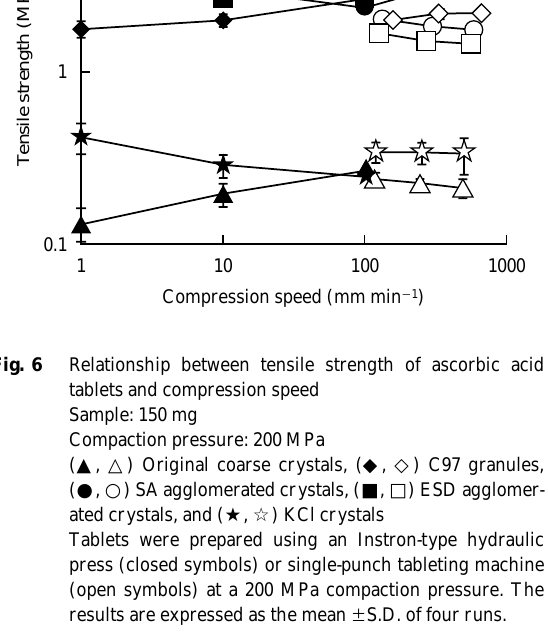
Relationship between tensile strength of ascorbic acid tablets and compression speed Sample: 150 mg Compaction pressure: 200 MPa ( ▲ , △ ) Original coarse crystals, ( ◆ , ◇ ) C97 granules, ( ● , ○ ) SA agglomerated crystals, ( ■ , □ ) ESD agglomer- ated crystals, and ( ★ , ☆ ) KCl crystals Tablets were prepared using an Instron-type hydraulic press (closed symbols) or single-punch tableting machine (open symbols) at a 200 MPa compaction pressure. The results are expressed as the mean (cid:5) S.D. of four